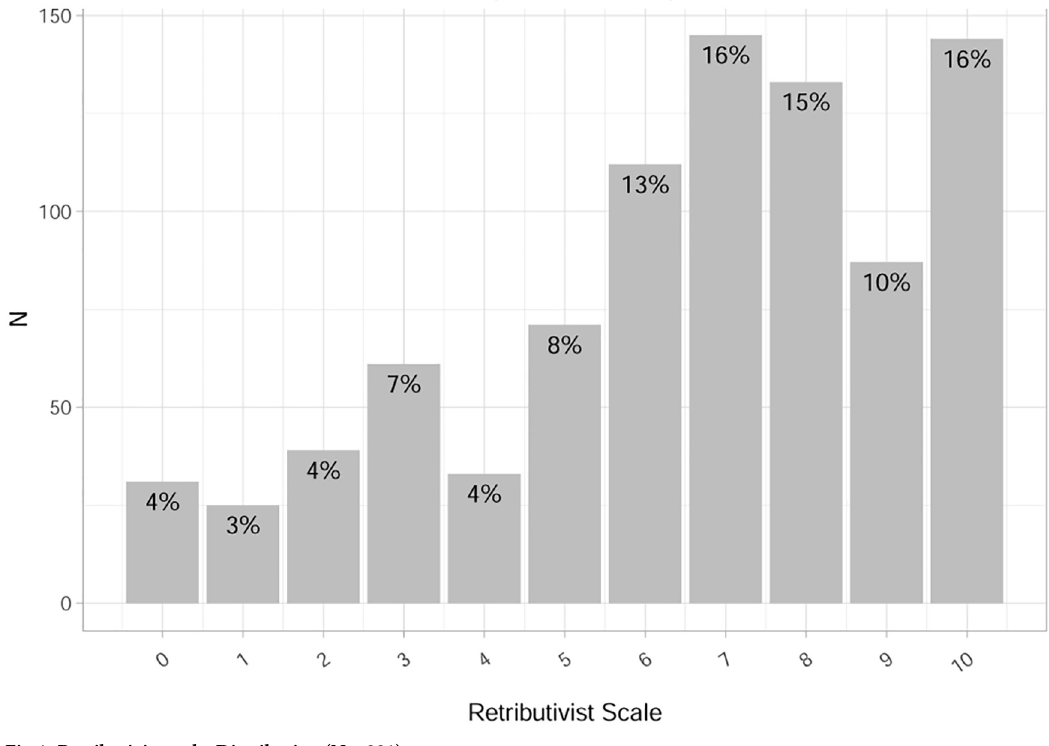
Fig 4. Retributivist scale: Distribution (N =